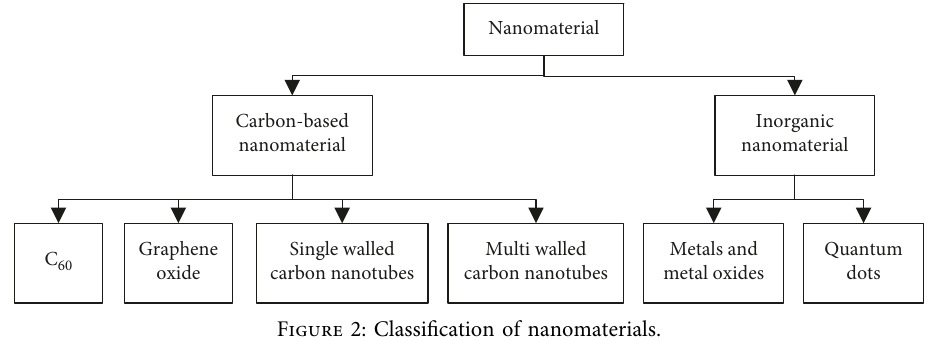
Figure 2: Classification of nanomaterials.